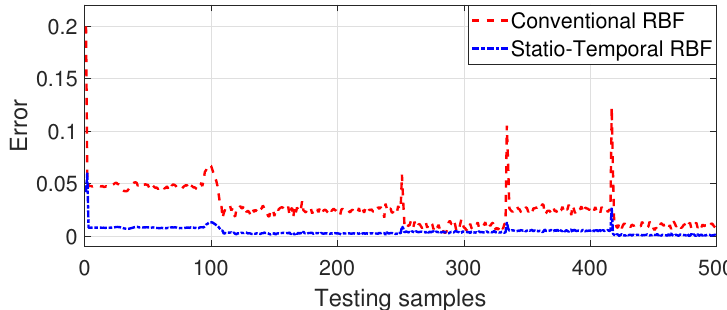
Figure 7. Prediction error of ST − RBF and conventional